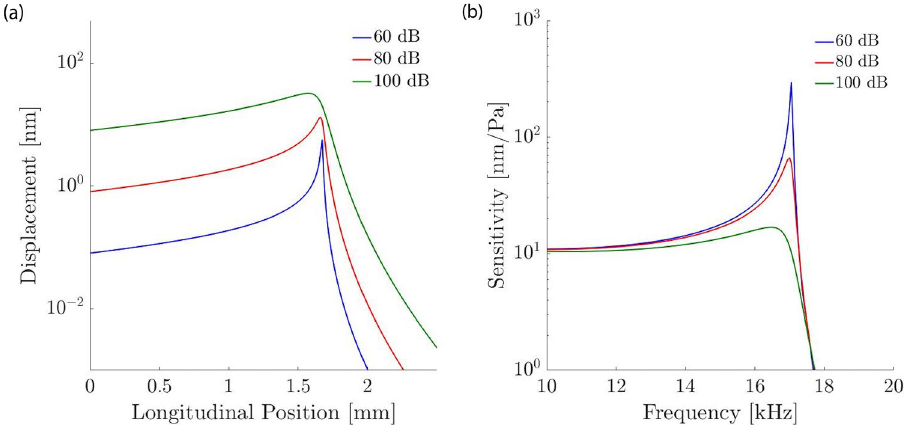
Figure 2. Amplitude dependent response of the basilar-membrane near the peak, modelled using a level- dependent drag coefficient ξ in the membrane impedance. ( a ) The membrane displacement increases linearly with the stimulation intensity basal and apical to the peak, but sublinearly at and near the peak. ( b ) The nonlinear response emerges clearly in the sensitivity, defined as the ratio of the membrane’s vibrational amplitude to the applied sound pressure. Where the sensitivity is independent of the sound-pressure level the membrane response is linear, but nonlinear otherwise. The compressive nonlinearity near the wave’s peak shows that the peak is sharper at lower stimulation